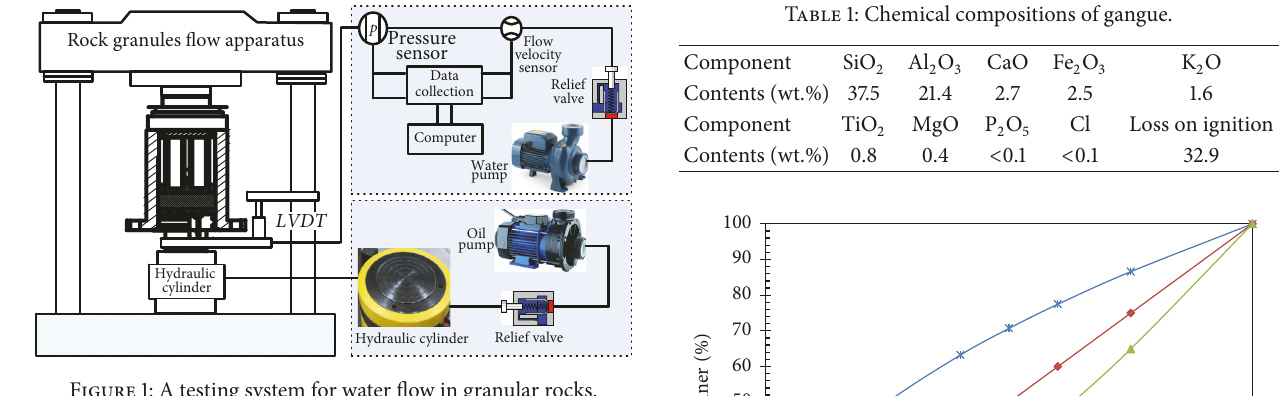
Figure 1: A testing system for water flow in granular rocks.